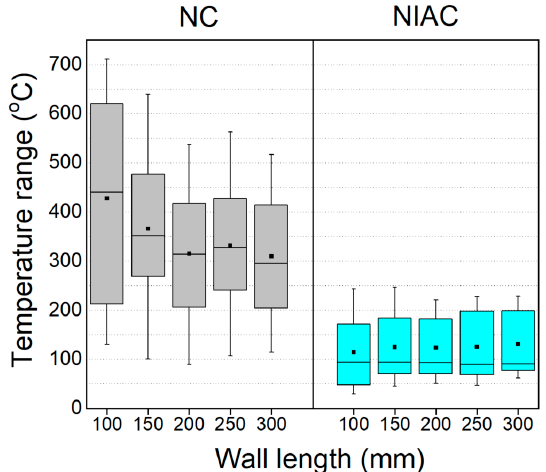
Figure 12. Effect of the deposition concentration on the geometry of walls with different lengths deposited with the NIAC (LEWD at 15 mm) and NC approaches.